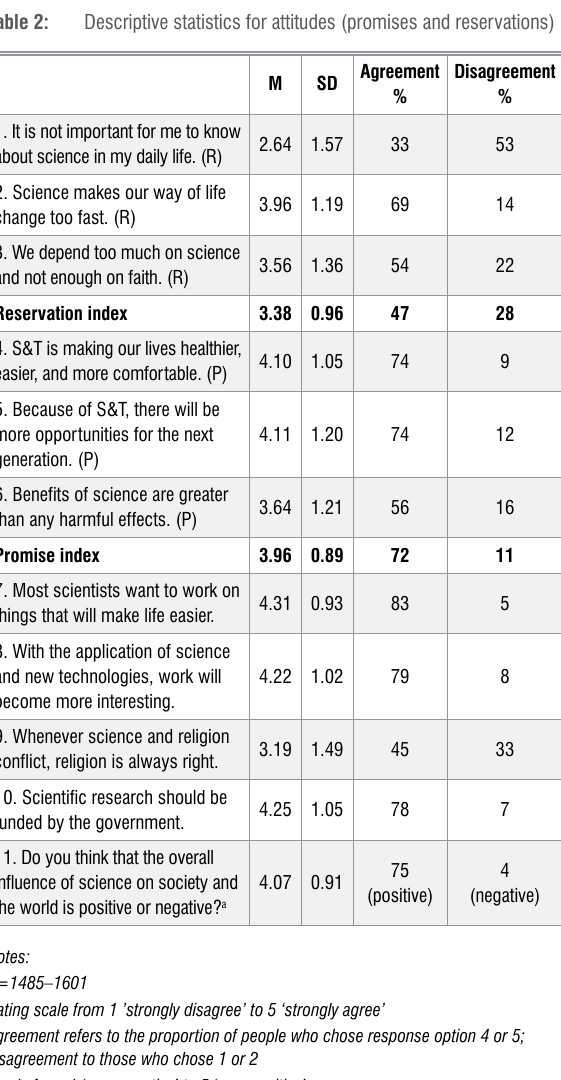
The sample for this